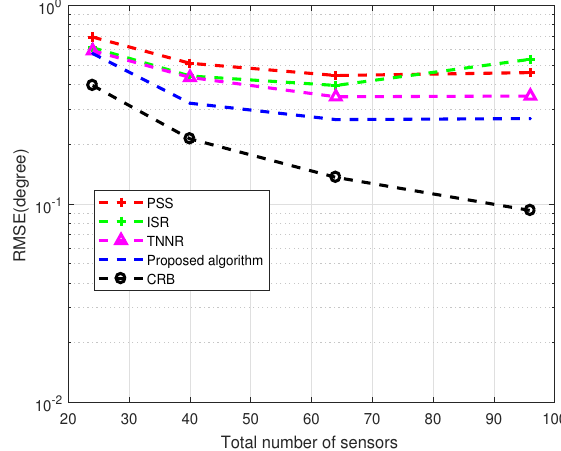
Figure 10. RMSE versus the total number of sensors.